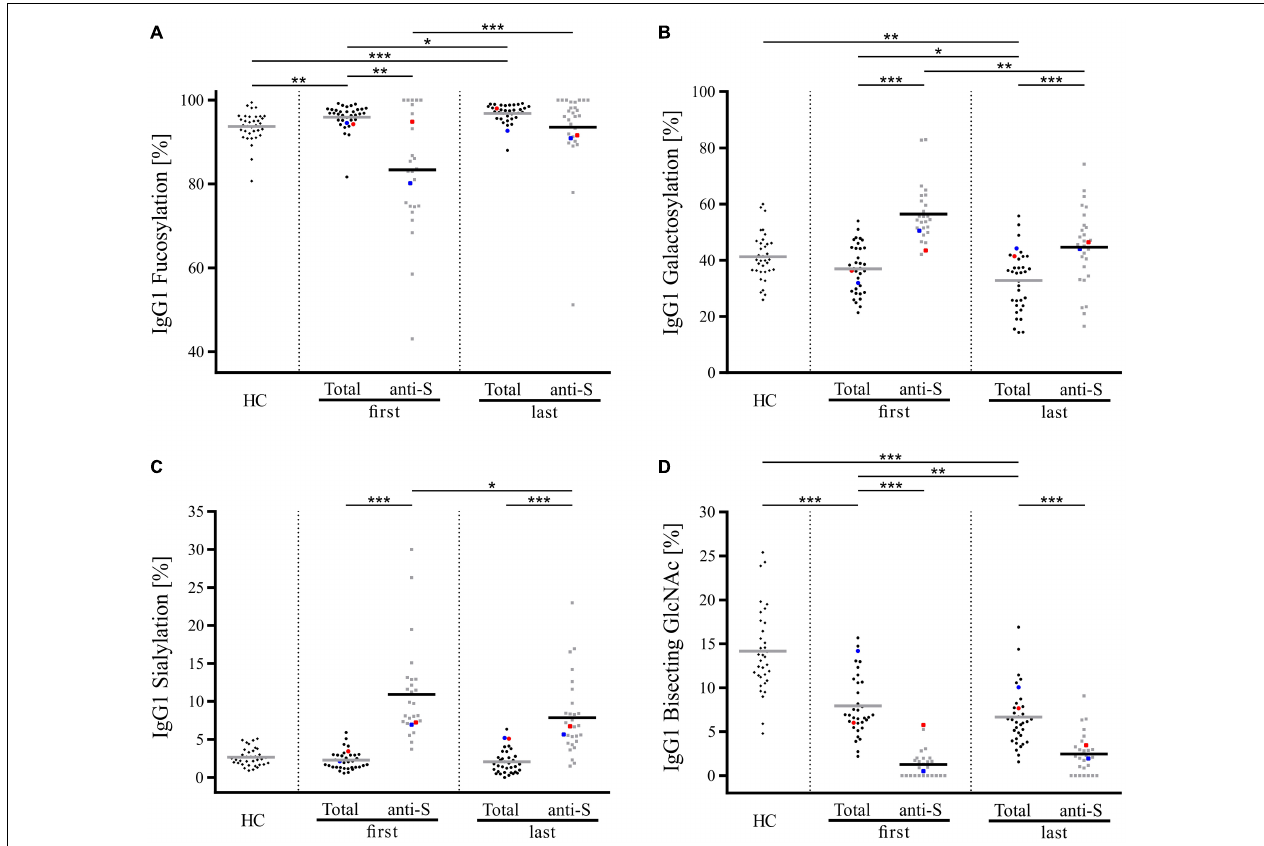
FIGURE 4 | Comparison of Fc glycosylation of total and anti-S IgG 1 in COVID-19 patients at the beginning and the end of hospitalization and total IgG 1 Fc glycosylation of healthy controls (HC). (A) Fucosylation, (B) galactosylation, (C) sialylation, and (D) bisecting GlcNAc. The calculation of the glycosylation traits Gal, Bisec, Sial, and Fuc is given in section “MALDI-TOF Measurements and Data Analysis.” Data points corresponding to the two deceased COVID-19 patients are indicated in red (patient 1) and blue (patient 2). The Bonferroni corrected p -values are indicated as * p < 0.05, ** p < 0.01, *** p <